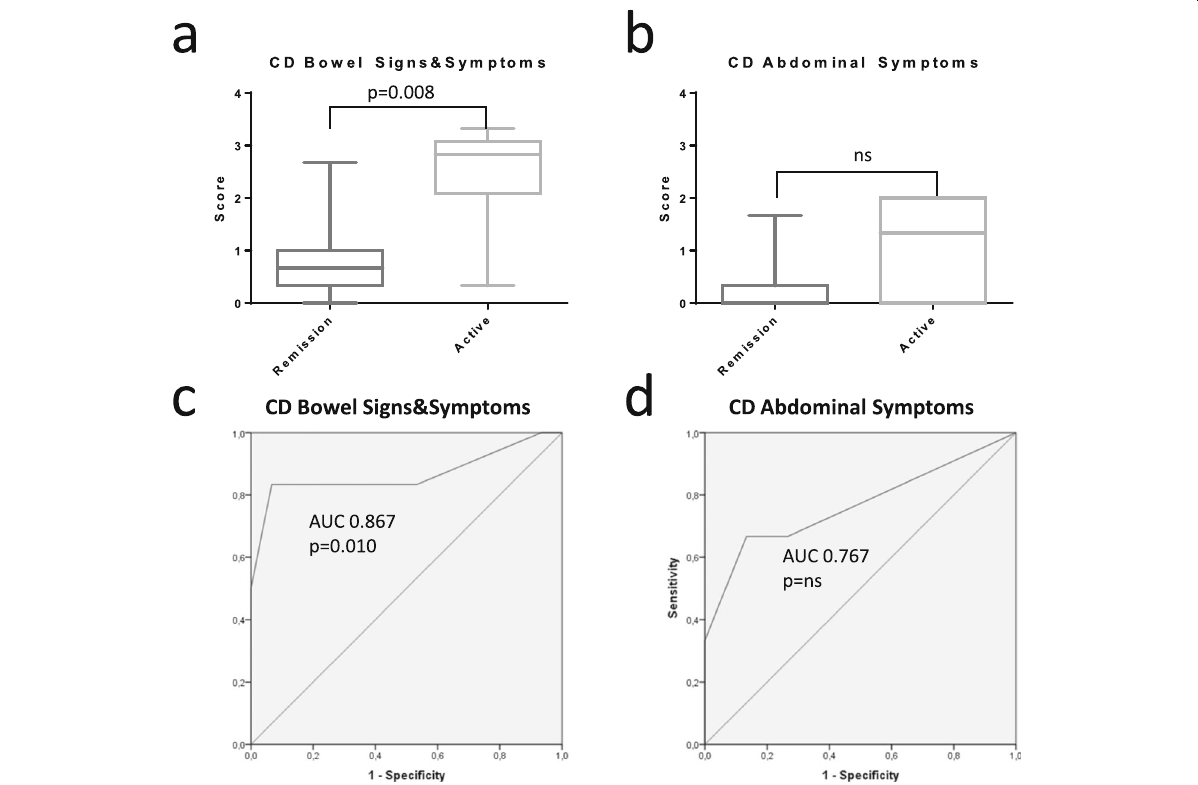
Fig. 1 CD bowel signs and symptoms ( a ) and abdominal symptoms ( b ) measures of patients defined in clinical remission or suffering from disease relapse (active) by global clinical assessment. ROC curves of CD bowel signs and symptoms ( c ) and abdominal symptoms ( d ) referred to disease activity status by global clinical assessment. Statistical significance of differences ( p value) is reported in the plot area. AUC: area under the curve. (ns) not